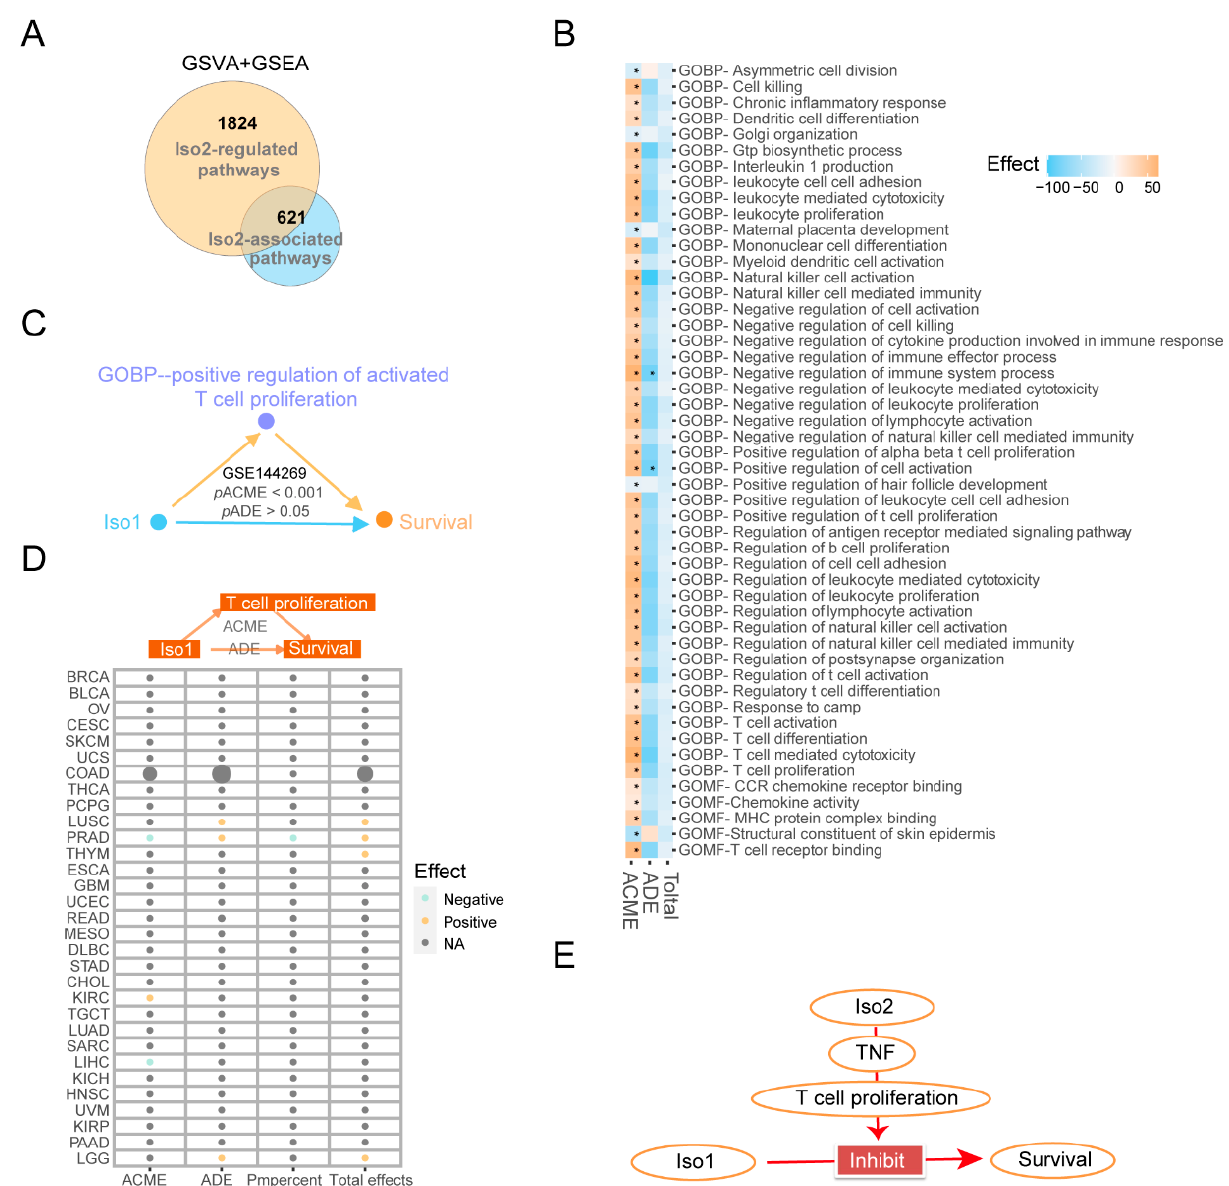
Figure 6. Dependency of the downstream immune pathways of Iso2 for the prognosis effect of Iso1. ( A )Venn diagram of the intersection between the downstream immune pathways of Iso2 and the key Iso1-associated pathways changed or reversed under expressional switch of Iso2. ( B – D ) The mediating effects of T cell proliferation on the prognostic effects of Iso1 determined by causal mediation analysis in the Mongolian liver cancer cohort and different TCGA sub-cohorts ( E ) The prognosis promotion effect relies on the Iso2-TNF-T cell proliferation